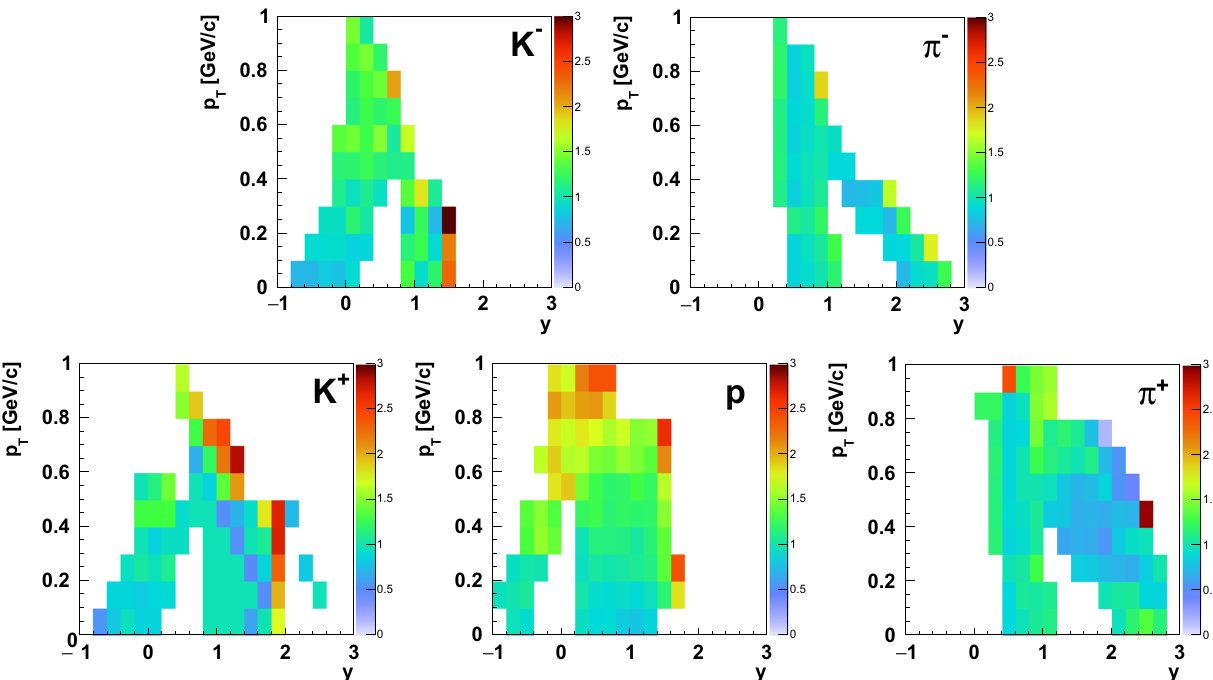
Fig. 39 Two dimensional distributions d 2 n /( dp T dy ) of π − , π + , K − , K + and p produced in inelastic p + p interactions at 20 GeV / c divided by the EPOS model [21] calculations